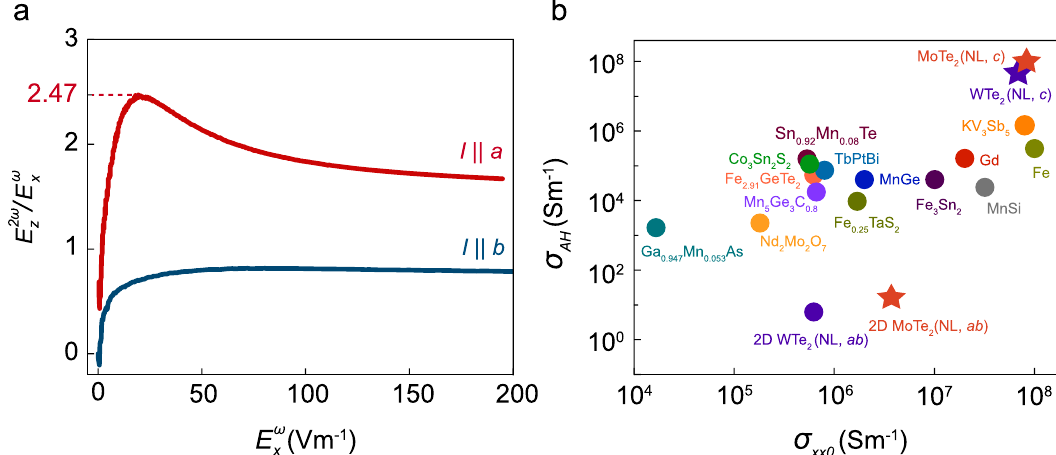
Fig. 5 Observation of extremely large Hall ratio and conductivity at higher bias. a Hall ratio E 2 ω z = E ω x vs E ω x for I k a and I k b in 127-nm-thick sample. Hall ratio reaches 2.47 for a -axis. b Anomalous Hall conductivity σ AH vs. σ xx 0 for various linear and nonlinear (NL) AHE materials. Stars mark values measured in this